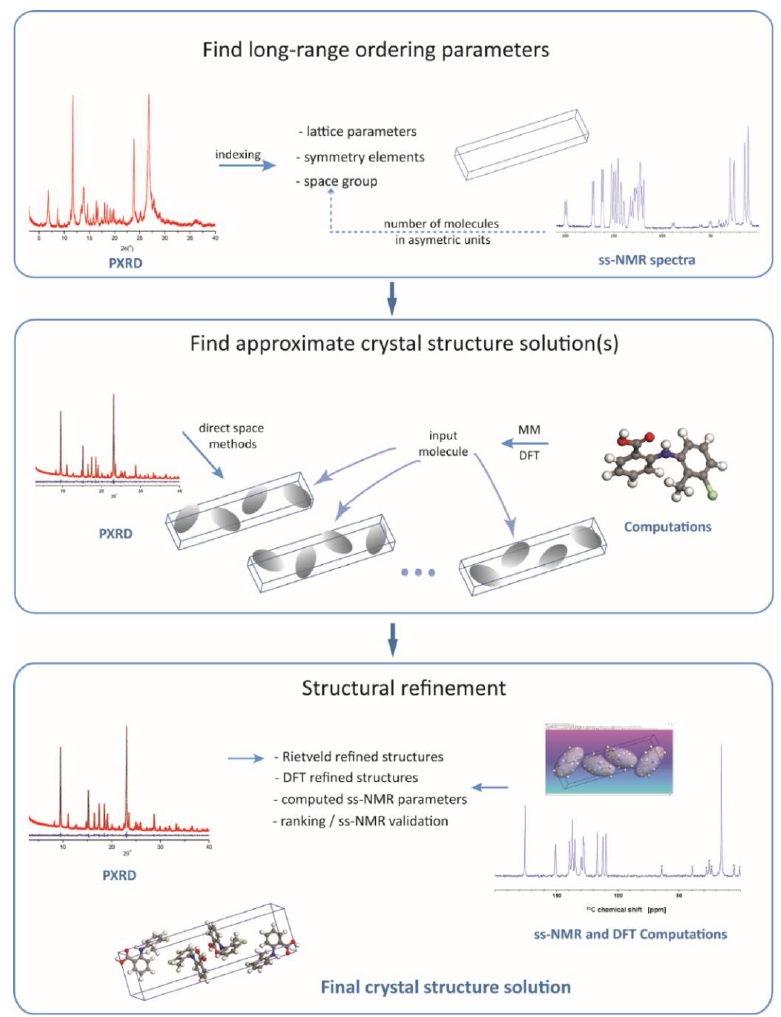
Figure 1. Schematic representation of the workflow used in an NMR crystallography approach to crystal structure determination.